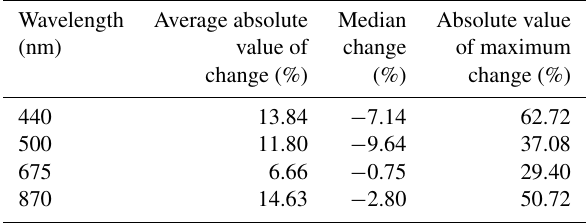
Table 3. Summary statistics for AMODv2 calibration stability test. All summary statistics refer to the change in V 0 (Eq. 2). Note that the absolute value of the maximum change refers to the single unit with the highest percent change for each